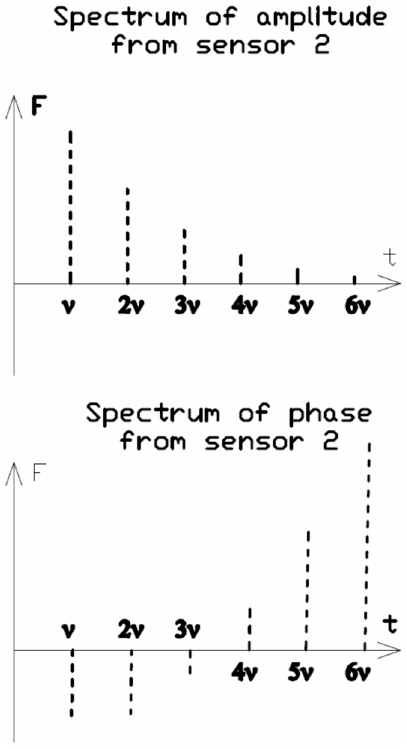
Figure 5. Amplitude and phase spectrum of the second sensor.